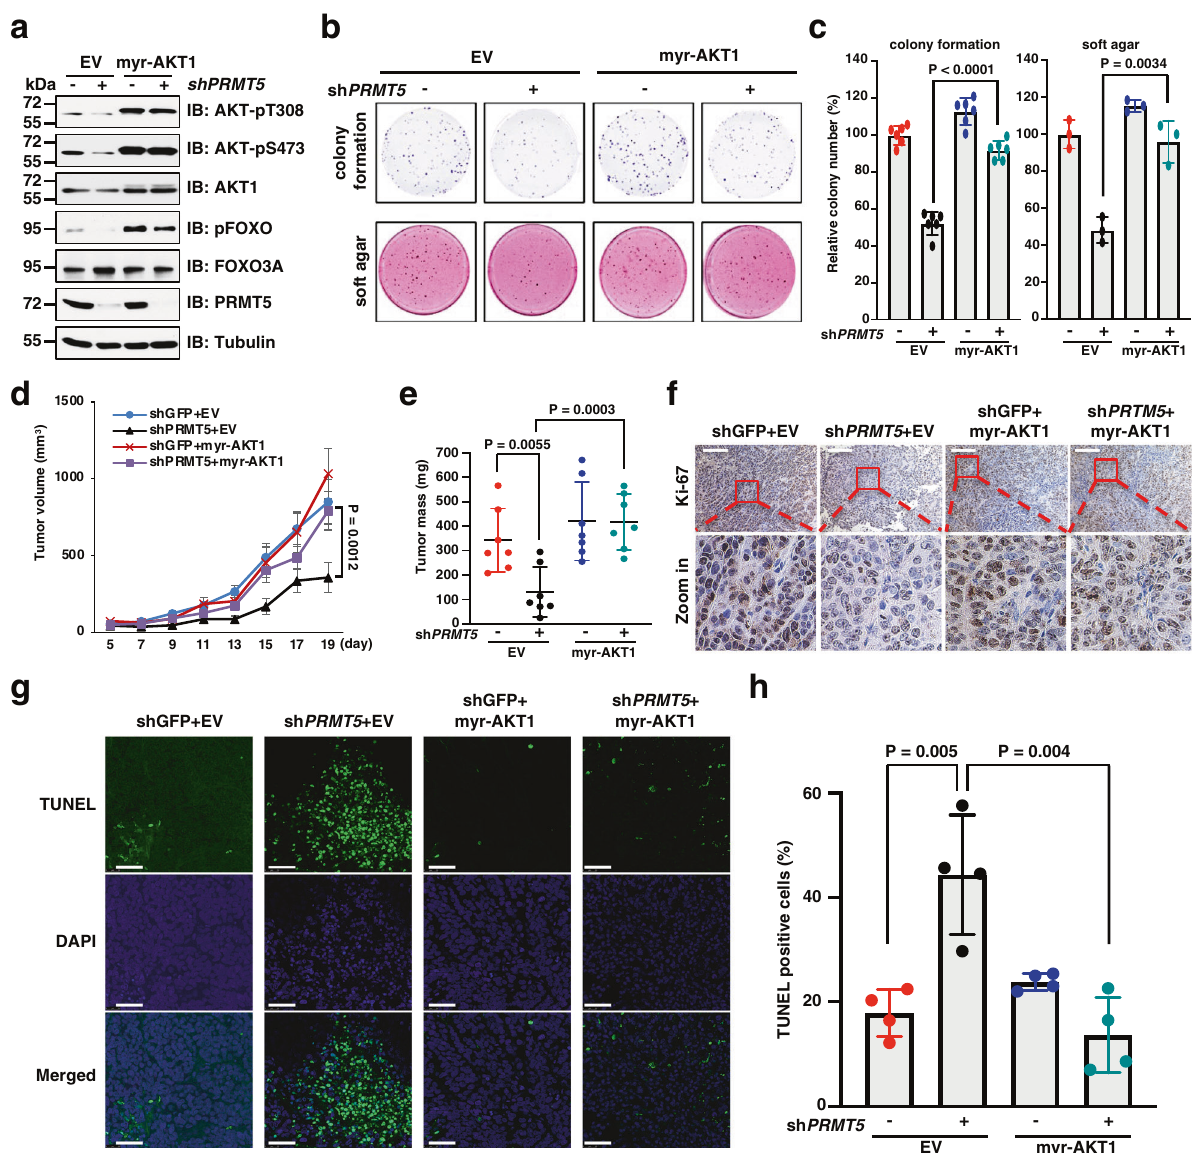
Fig. 2 AKT rescues cell proliferation and tumor growth of PRMT5 -depleted cells. a MCF7 cells stably expressing myr-AKT1 were infected with shRNA targeting PRMT5 and subjected to IB analysis. Similar results were obtained in n = 3 independent experiments. b , c Cells generated in a were subjected to colony formation and soft agar assays. Representative images are shown in b and relative colony numbers are plotted in c . Data are shown as the mean ± SD of n = 3 or 6 independent experiments. d DLD-1 cells ectopically expressing myr-AKT1 and/or depleting PRMT5 were injected into nude mice. Tumor growth was monitored for the indicated time period. Data are shown as the mean ± SEM for n = 7 mice. e Weight of the tumors. Data are shown as the mean ± SD for n = 7 tumors. f Representative images of IHC staining of Ki-67 in n = 4 xenograft tumors. Scale bar, 100 μ m. g Representative images of TUNEL assays in xenograft tumors. Scale bar, 50 μ m. h Quanti fi cation of TUNEL-positive cells in xenograft tumors. Data are shown as the mean ± SD for n = 4 tumors. Statistical signi fi cance was determined by two-tailed Student ’ s t -test in c , e , h and by two-way ANOVA in d . Uncropped immunoblots and statistical source data are provided in Source Data fi